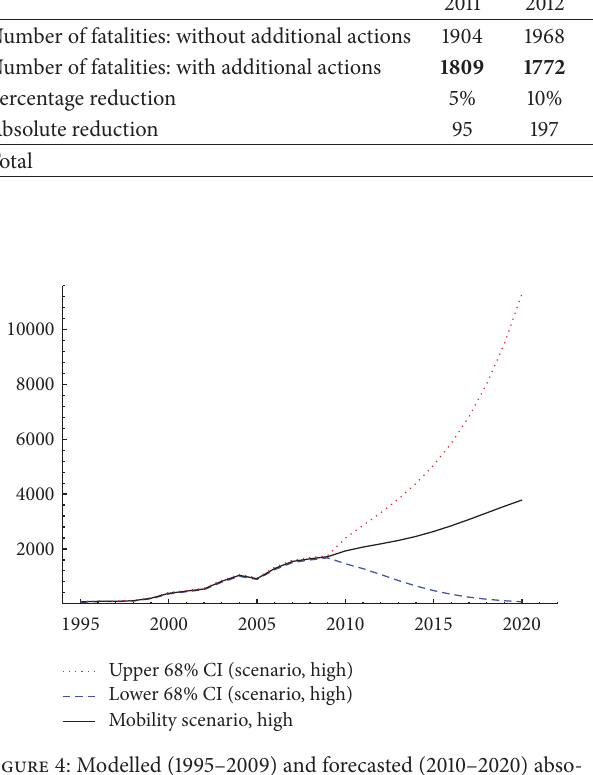
Figure 4: Modelled (1995–2009) and forecasted (2010–2020) abso- lute numbers of Cambodian fatalities, including their 68% confi- dence limits, according to the high vehicle growth scenario.